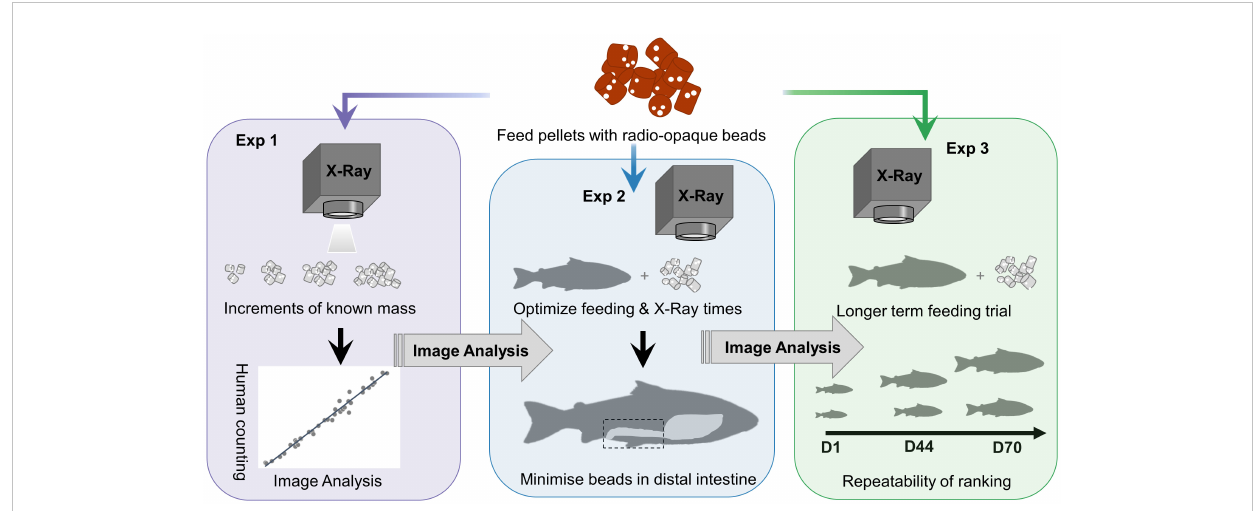
FIGURE 1 Graphical summary of each of the three sequential experiments conducted to adapt and assess the use of the X-ray method in Atlantic